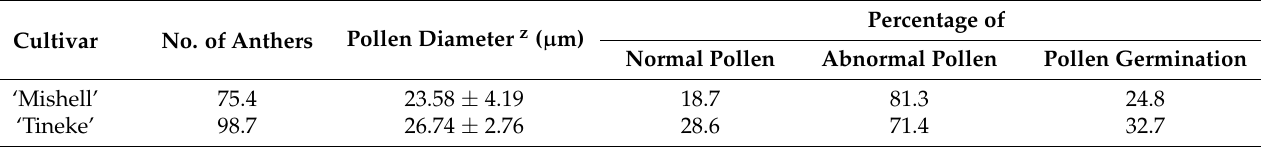
Table 5. Anther and pollen paternity characteristics.